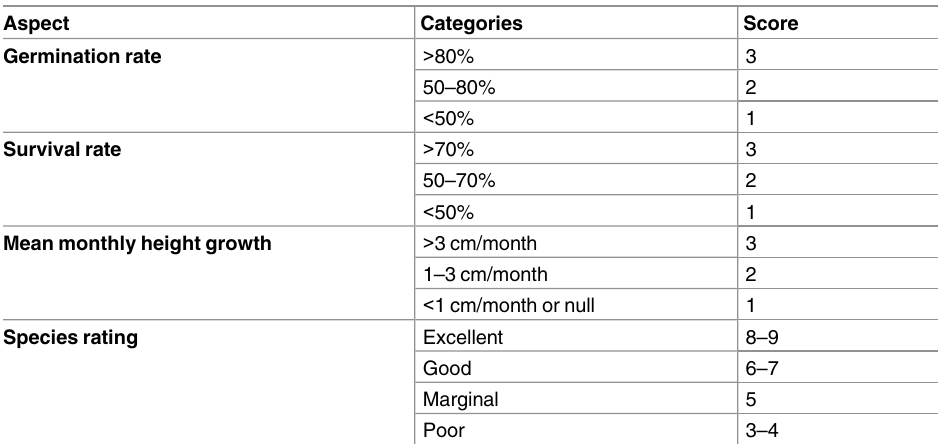
Table 2. Species